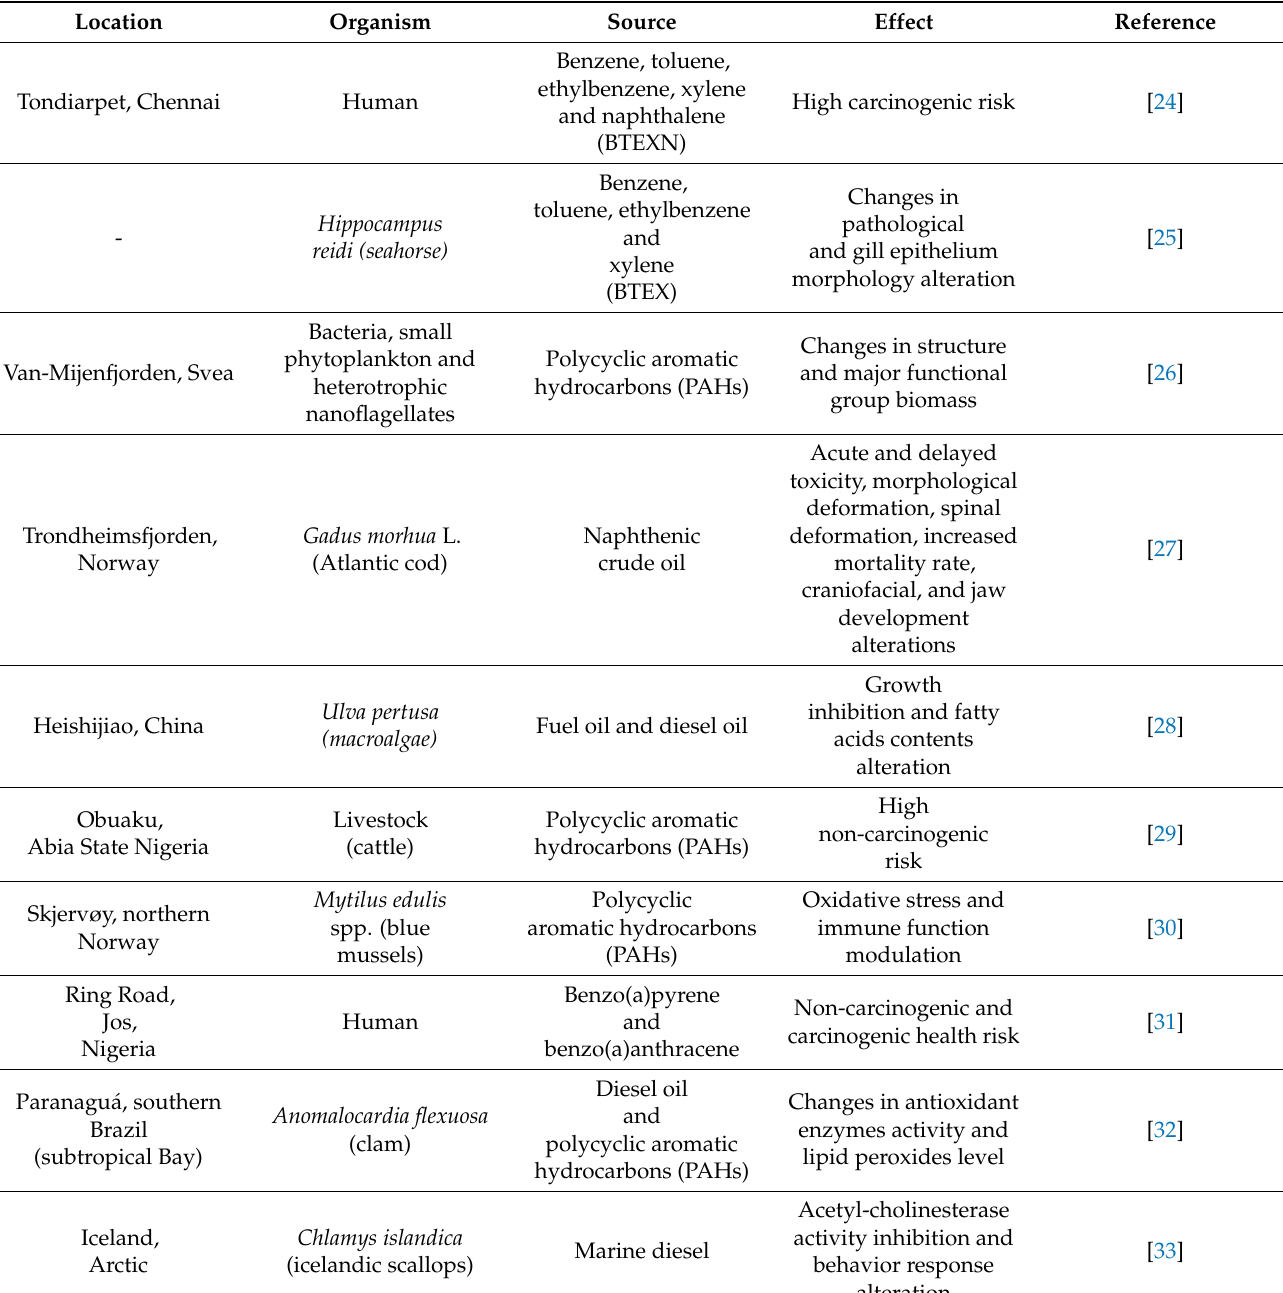
Table 1. Effects of oil spills on different